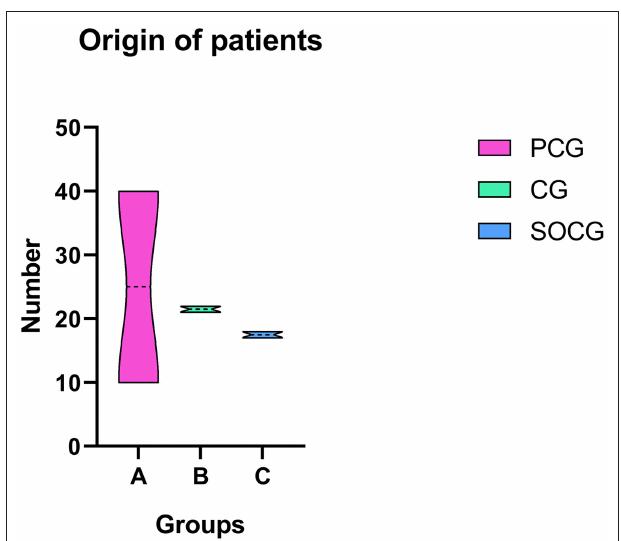
FIGURE 2 | Origin of patients: We received more patients from other provinces in the COVID-19 period ( P < 0.05). Pre-COVID-19 group-PCG